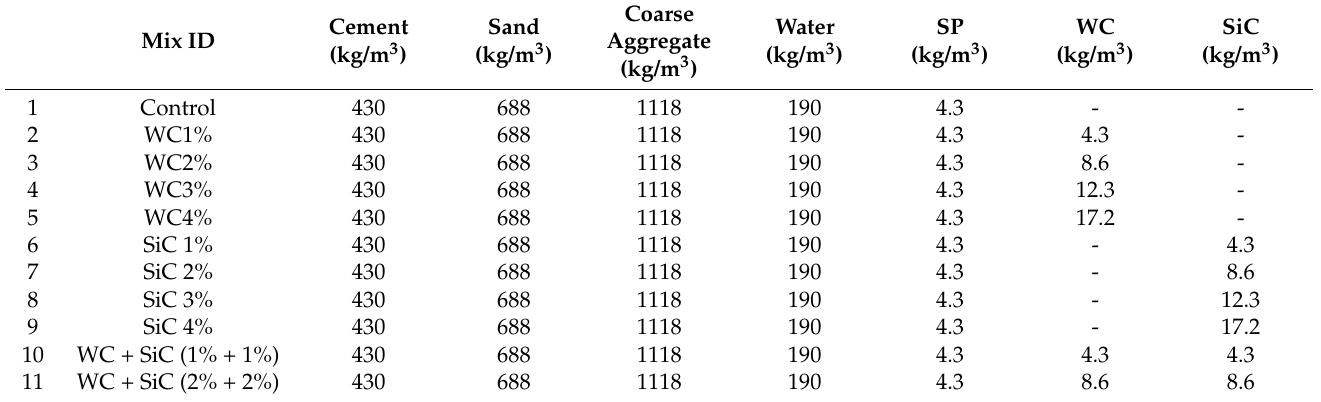
Table 3. Composition of Prepared